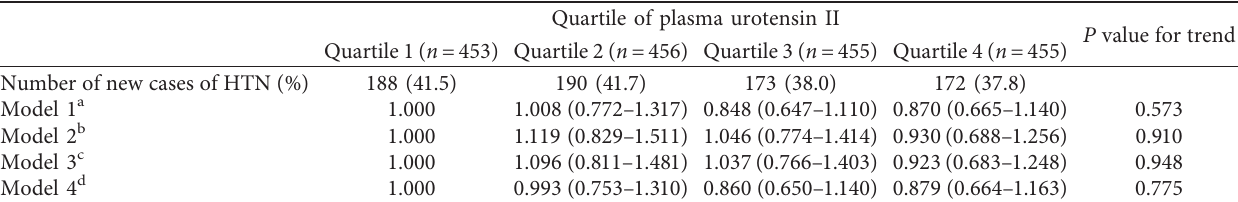
Table 3: Odds ratios for risk of hypertension comparing the three higher quartiles with the lowest quartile of baseline urotensin II levels. Quartile of plasma urotensin